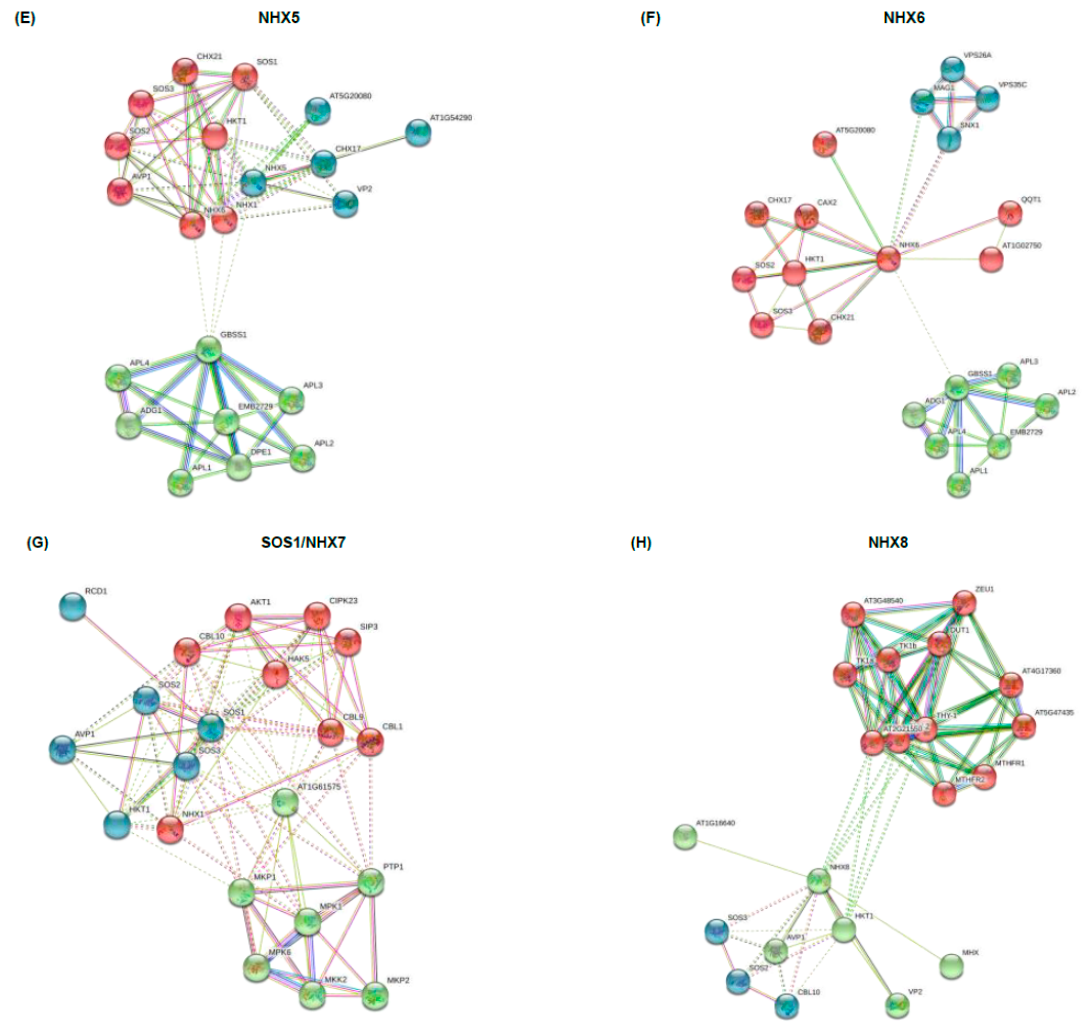
Figure 5. Protein–protein interaction networks involving the Na + /H + antiporters (NHXs). The interaction networks of NHX1 ( A ), NHX2 ( B ), NHX3 ( C ), NHX4 ( D ), NHX5 ( E ), NHX6 ( F ), SOS1 / NHX7 ( G ) and NHX8 ( H ) with other proteins were constructed by the STRING web-server. Network nodes represent proteins. Network is clustered to three clusters, which are represented with red, green and blue nodes, respectively. Colored nodes: query proteins and first shell of protein interactors; white nodes: second shell of protein interactors. Empty nodes: proteins of unknown 3D structure; filled nodes: some 3D structure is known or predicted. Edges represent protein–protein associations.